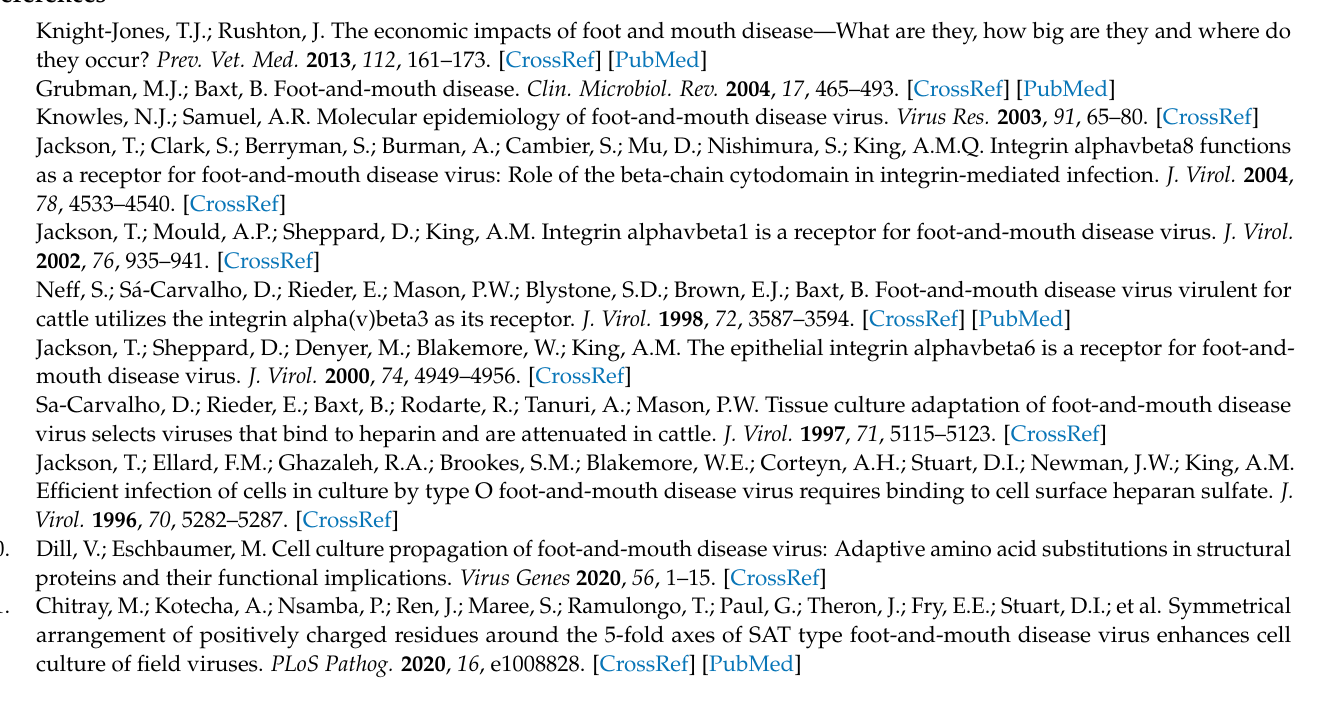
Strain 35; Figure S2: Analyses of α v β 6 expression by monoclonal cell lines derived form SP38-Mix BHK-21; Figure S3: Analyses of α v β 6 expression by SP38-High BHK-21; Figure S4: Assessment of Ad38-Mix as a diagnostic cell line to observe cytopathic effect (CPE); Table S1: Virus neutralisation Tests using SP38-Mix and non-cell culture adapted